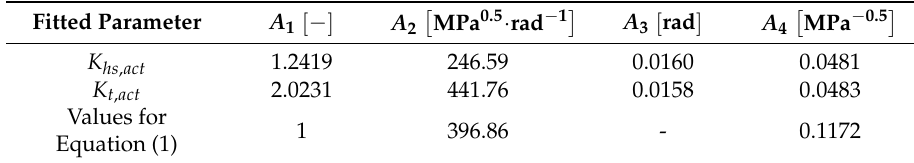
nominal stresses.